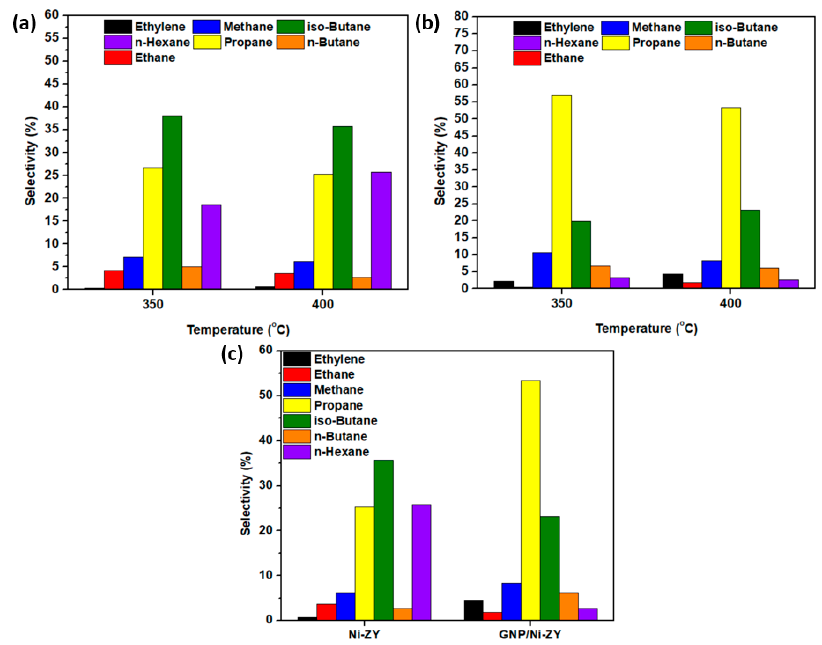
Figure 7. Selectivity towards various products over ( a ) Ni-ZY and ( b ) GNP/Ni-ZY as well as ( c ) both selectivities compared at 400 °C.